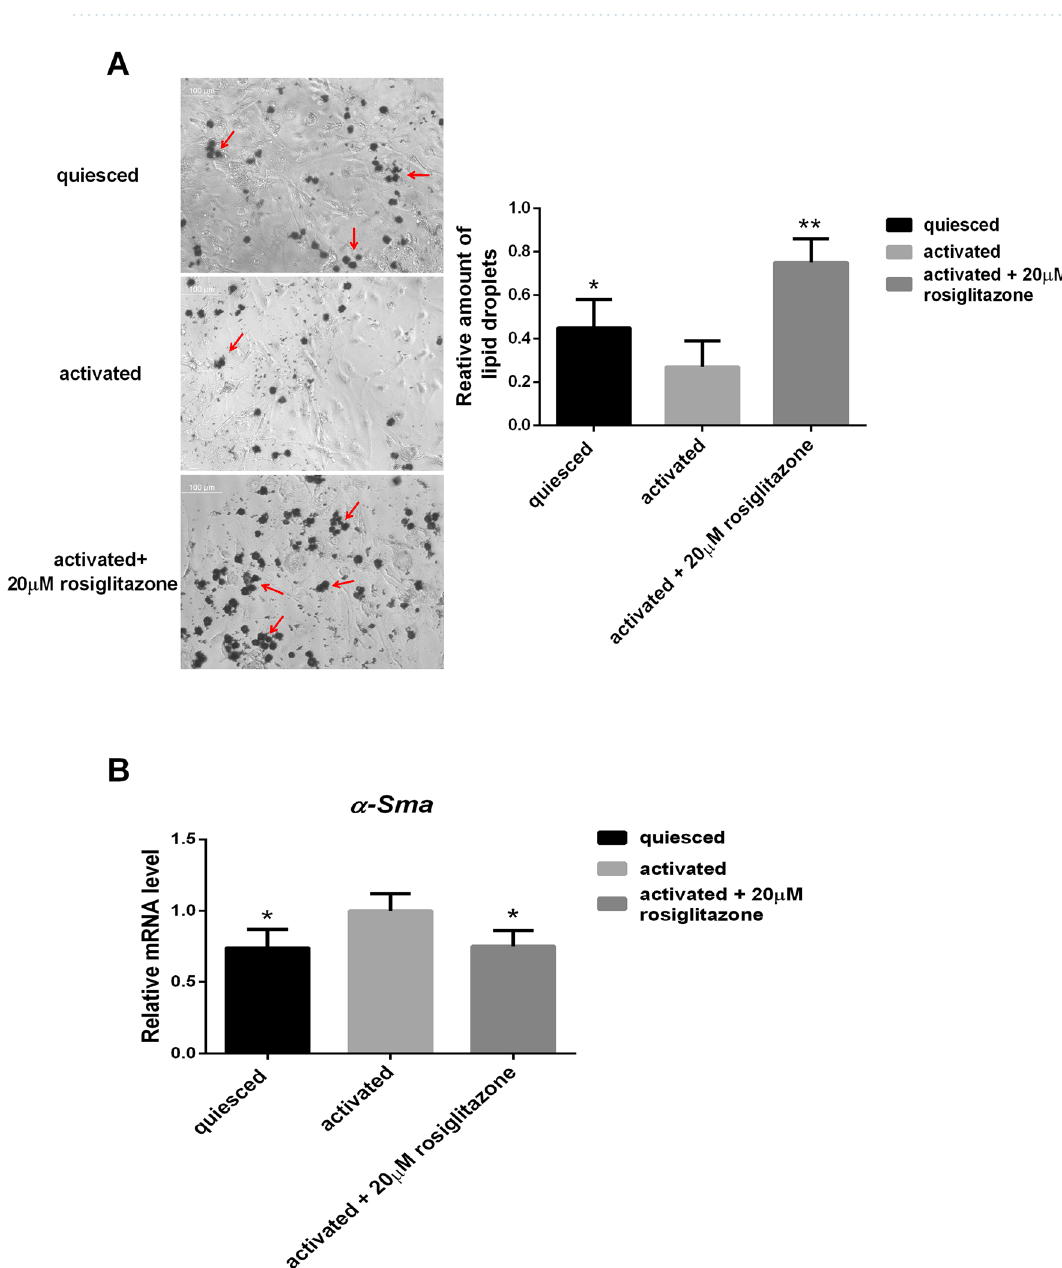
Figure 4. Lipid droplets and the mRNA expression levels of the fibrotic marker α-SMA in LX-2 cells. ( A ) Lipid droplets in LX-2 cells were stained by Oil Red O and quantitatively detected. Oil red O staining in activated LX-2 cells significantly decreased, while staining markedly increased after the addition of 20 µM of the PPARγ agonist rosiglitazone ( n = 3). Arrows refer to the stained lipid droplets. ( B ) Compared with quiesced cells, the mRNA level of α-SMA in activated LX-2 cells increased, while the α-Sma gene was conspicuously suppressed by 24 h of treatment with 20 µM rosiglitazone ( n = 3). Mean values ± SD are presented. ## P < 0.01 vs . the activated LX-2 group, # P < 0.05 vs . the activated LX-2